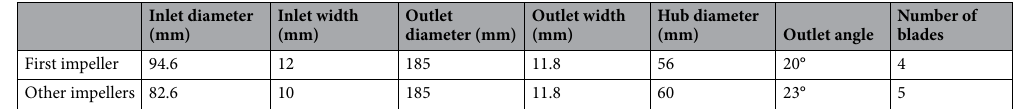
Table 2. Structural parameters of the